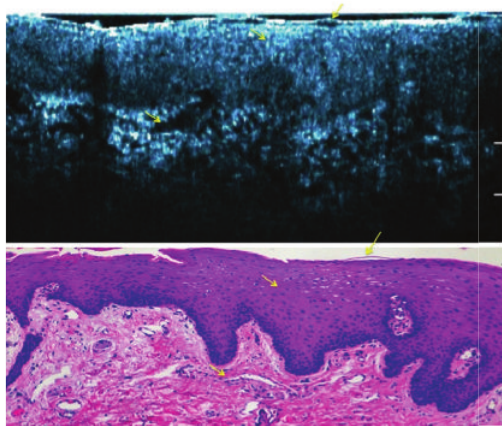
Figure 4: High-definition optical coherence tomography “slice” image with histologic correlation. Yellow arrows pinpoint the ana- tomical correlation between the “slice” image obtained with HD- OCT and the histology image.